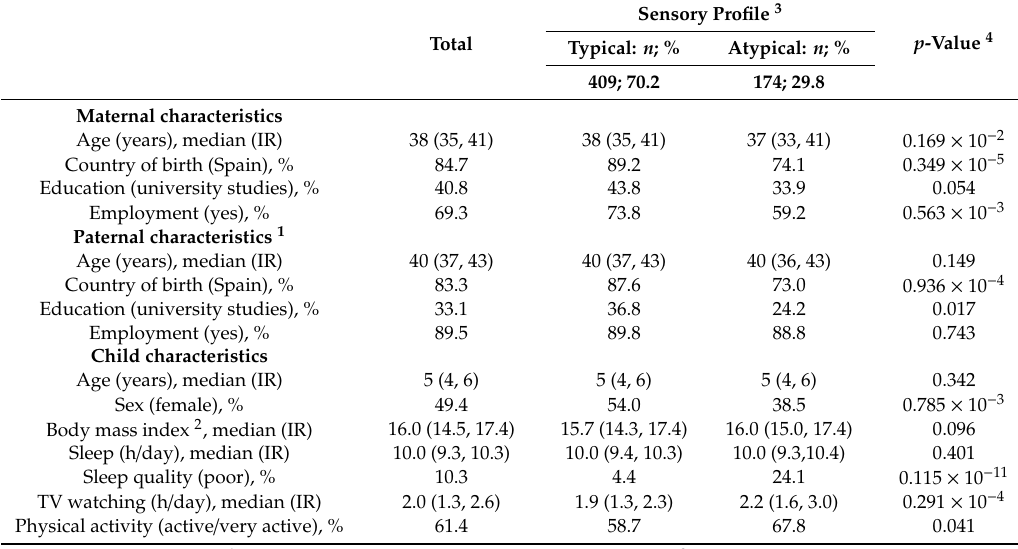
Sensory Profile 3 p -Value 4 Typical: n ; % Atypical: n ; % Total 409; 70.2 174; 29.8